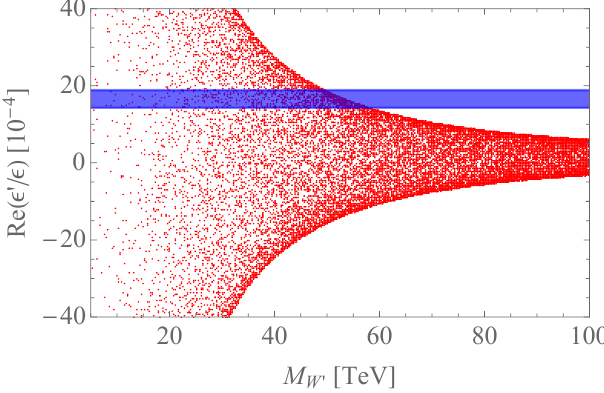
Figure 2 . Numerical result of Re( (cid:15) 0 =(cid:15) ). The blue band represents the experimental data given by PDG [8], while each red dot corresponds to the model prediction with a randomly generated set of ( (cid:11) (cid:0) d , (cid:11) (cid:0) s